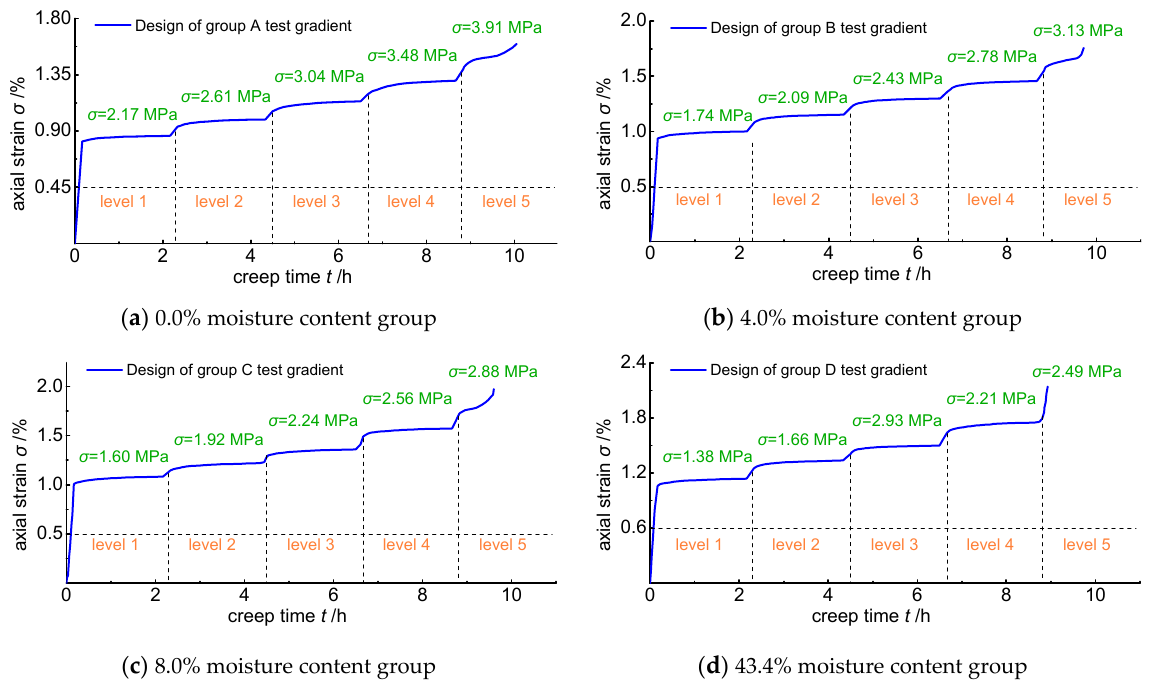
Figure 5. Strain variation curves of specimens with different water content.